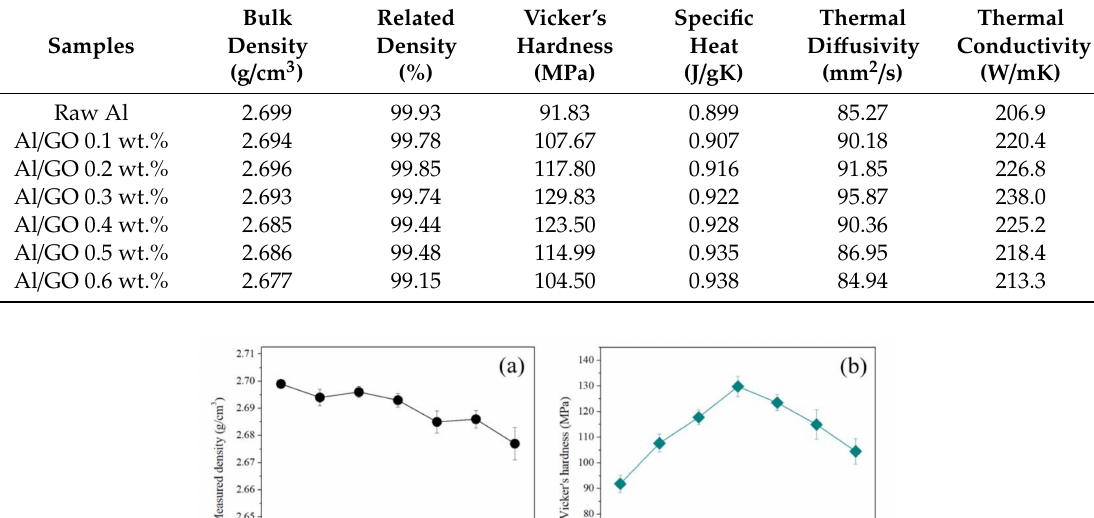
Table 2. Comparison of the mechanical and thermal properties of all the samples.